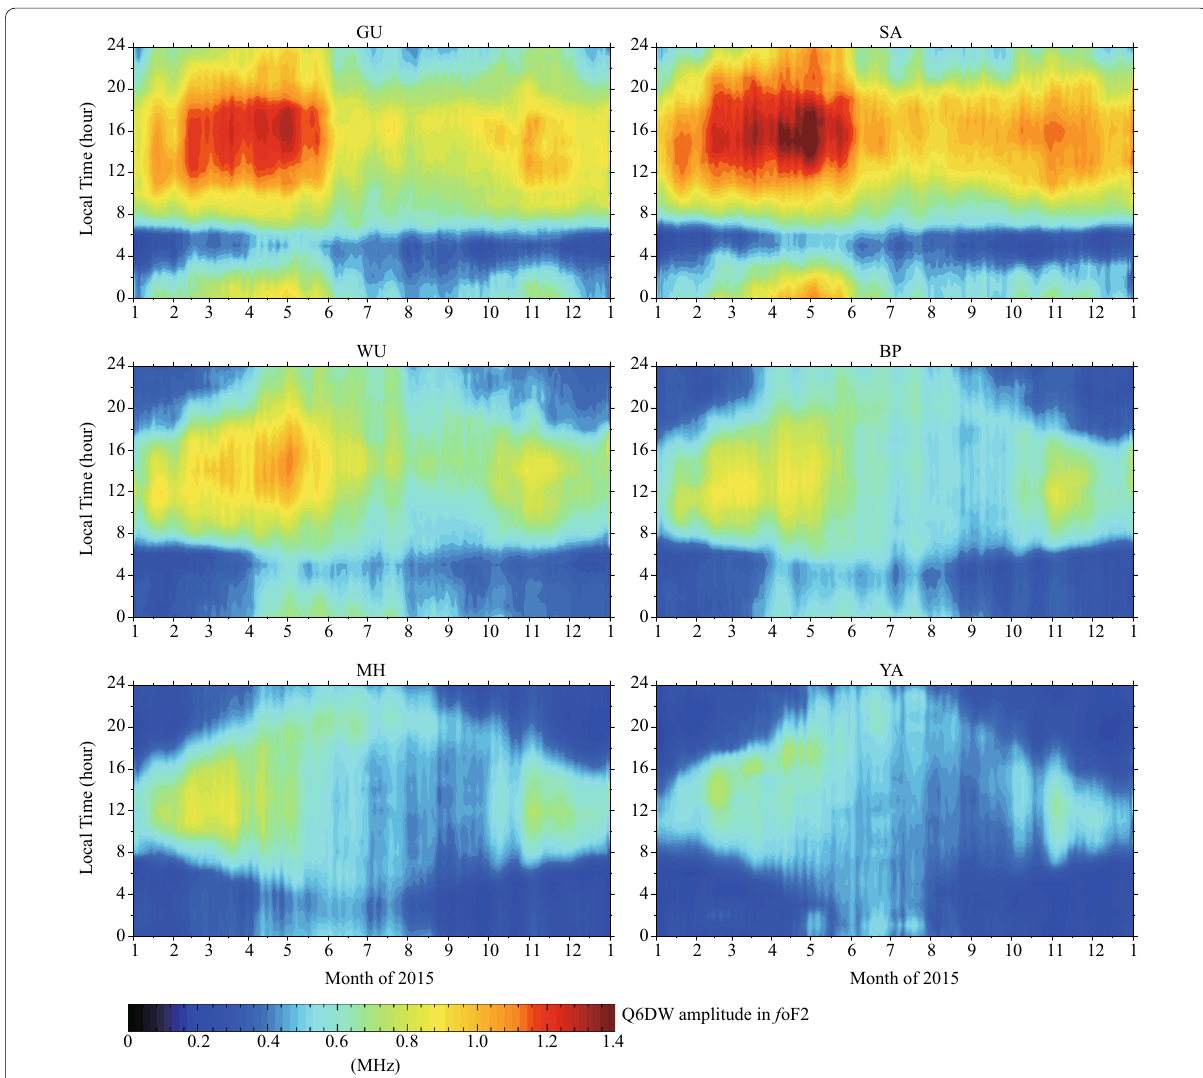
Fig. 9 Average amplitude of Q6DW (s 1) in f oF 2 during 2015 at Guam (GU), Sanya (SA), Wuhan (WU), Beijing (BP), Mohe (MH) and Yakusk =